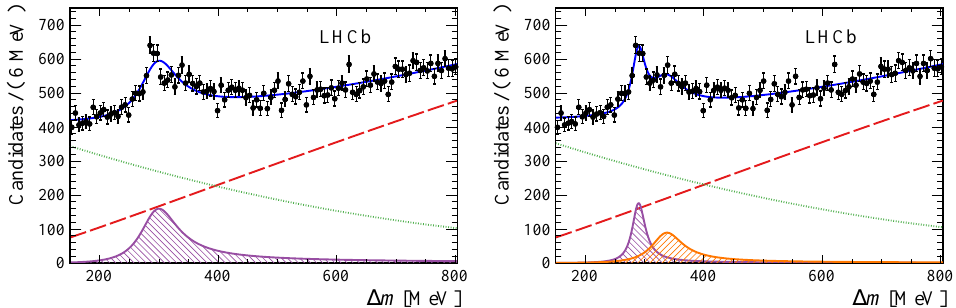
> 2GeV, the B + K − mass difference T